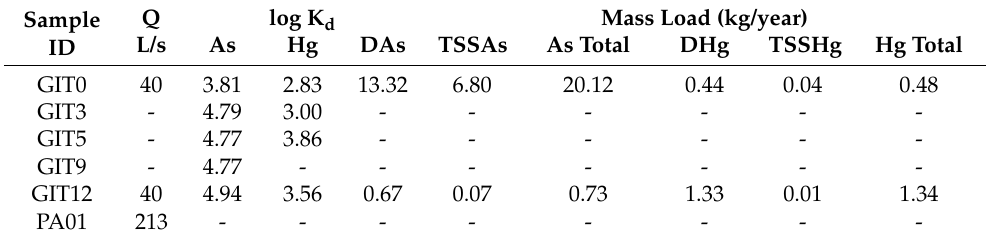
Table 4. Log-transformed partition coefficient (reported as log Kd) for As and Hg along FdC.